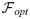
Context-enhanced odor processing in cluttered environments: Occluding stimulus.(A,D) Training stimuli 1,2 and 3,4 were associated with contexts 1 and 2, respectively. (B,C) Learned disynaptic inhibitory connections among MCs (W(MM)) and from CCs to MCs (W(MC)). The color indicates the number of GC mediating the respective connections. (E) Probe stimuli consisted of a weak target odor (red line) with or without stimulus 1 as a strong occluding odor (black line). (F,G) MC activities resulting from the probe stimuli with and without context 1. Red: target with occluder, black: occluder alone. Context 1 reduced the response to the occluder, enhancing the detectability of the target. (H) Context 1 increased the Fisher discriminant Fopt when the occluding odor was present, but reduced Fopt when it was absent. With top-down input blocked (wGC = 0) the occluder is suppressed even less than without any context, deteriorating the performance further. The error bars indicate the standard deviation in Fopt resulting from fluctuations in the network connectivity.